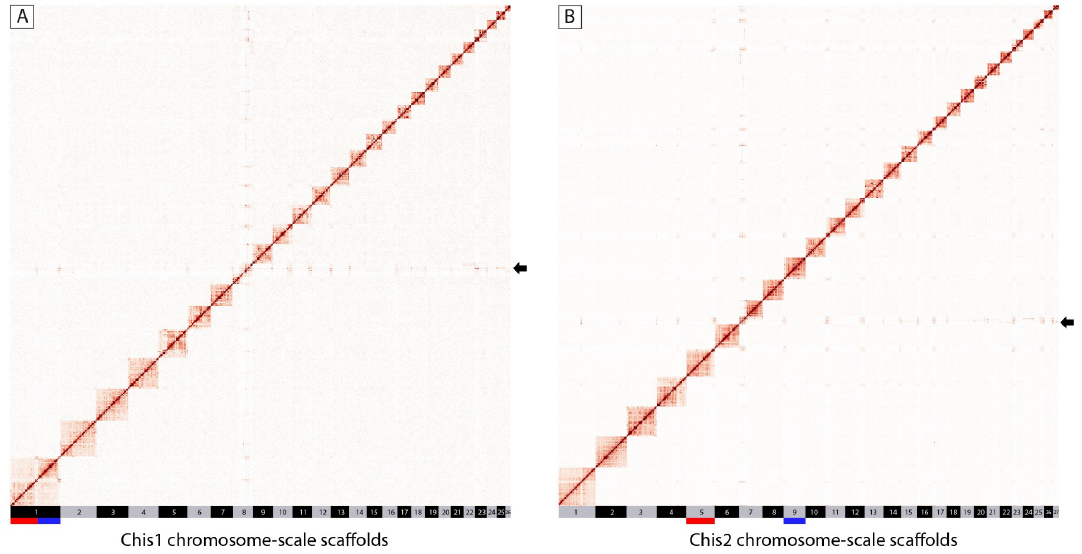
Figure 2: Assembly of the Cataglyphis hispanica Chis1 (A) and Chis2 (B) genomes into chromosomes. Hi-C interaction map revealing the presence of 26 and 27 linkage groups. The color scale represents the interaction frequencies. The positions of the rearranged chromosome are indicated, and the arrows show the assembly artefact found in each genome (see main text). The longest chromosome of Chis1 is split in two chromosomes in Chis2 (scaffolds 5 and 9, shown with red and blue colors).